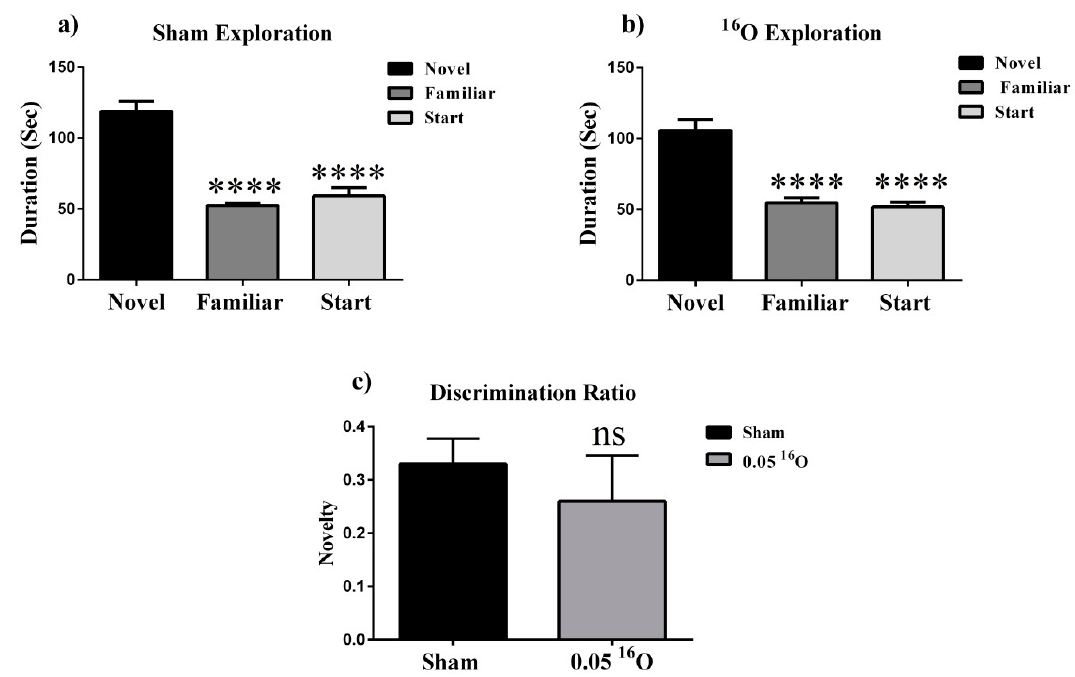
Figure 1. Y-maze. ( a – c ) All treatment groups spent significantly more time exploring the novel arm during the testing phase of the Y-maze, indicating no short-term memory deficits. Average ± standard error of the mean (SEM) ( n = 12); **** p < 0.001.